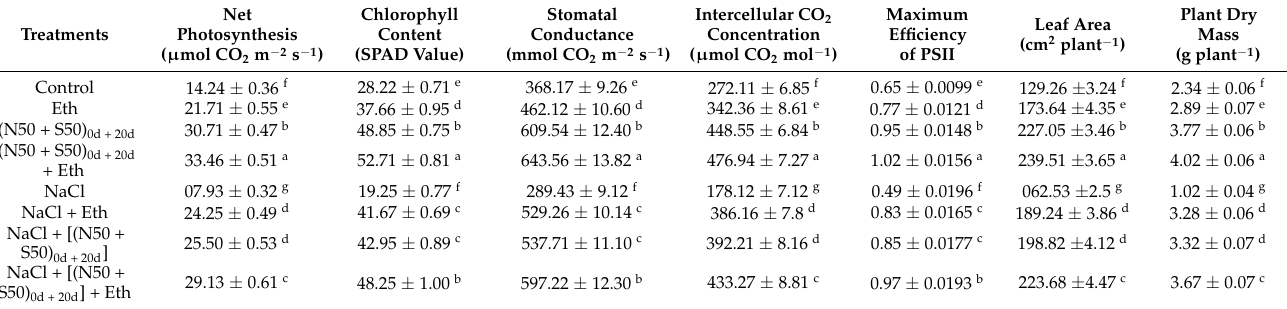
Table 1. Net photosynthesis, chlorophyll content, stomatal conductance, intercellular CO 2 concentration, leaf area and plant dry mass in mustard at 40 DAS. Plants were raised with split dosage of N and S (50 + 50 mg kg − 1 soil) at sowing time (0 DAS) and at 20 DAS, and plants were treated with 200 µ L L − 1 ethephon (Eth) in the absence or presence of 100 mM NaCl. Values are presented as means ± SE ( n = 4). Data followed by the same letter are not significantly different by LSD test at p < 0.05. DAS: days after